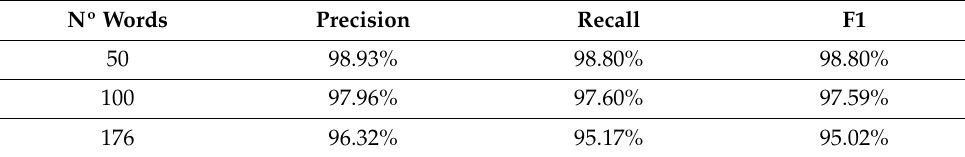
Table 3. Quality parameters.